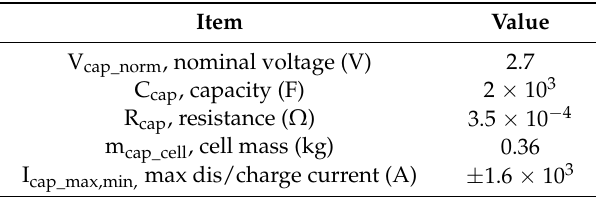
Table 2. Basic parameters of the SC